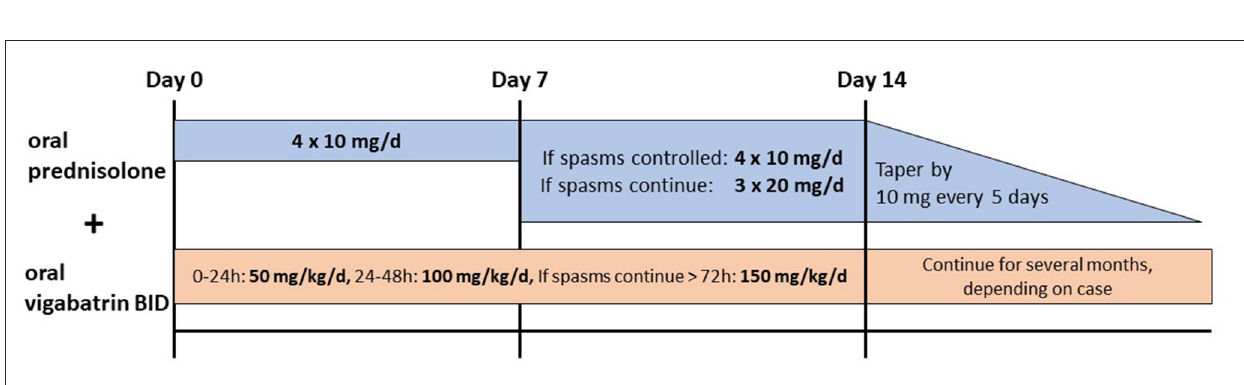
FIGURE2 Recommended treatment for epileptic spasms by the International Collaborative Infantile Spasms Study (ICISS) (26).